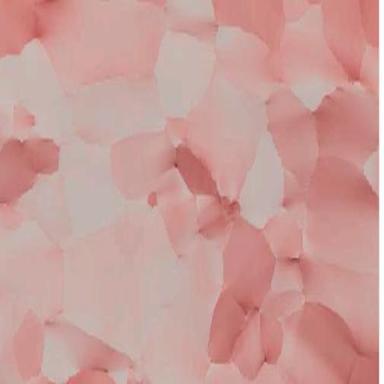
Comparison of microstructural results at 5% compressive strain obtained from simulation and experiment. Compression direction is vertical. Figure adopted from with permission from Elsevier.